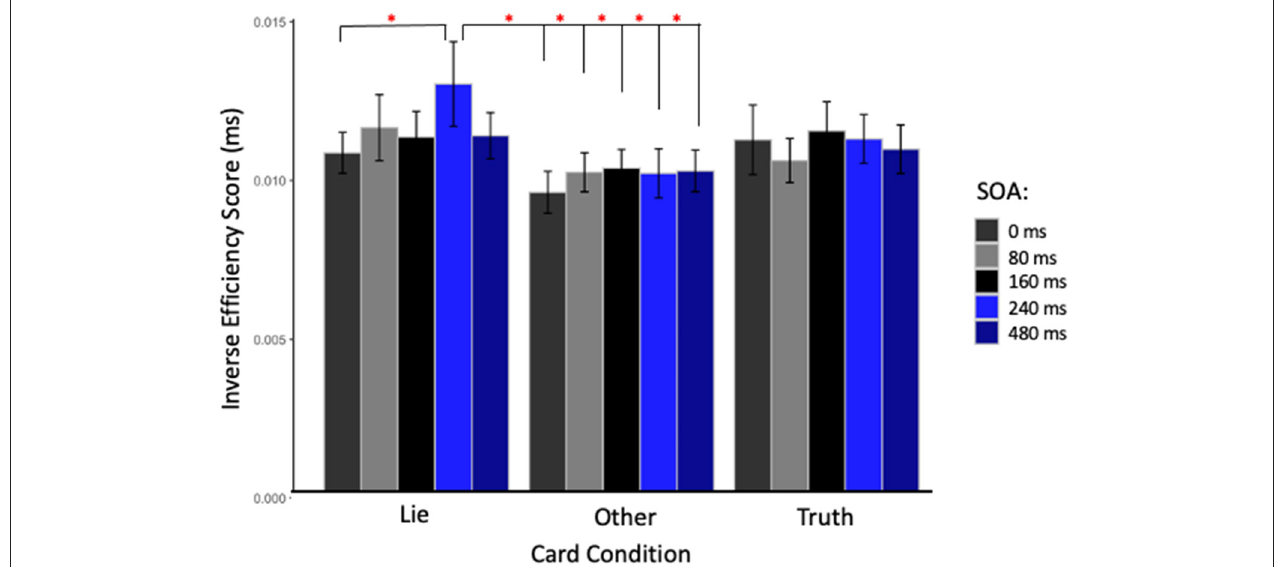
FIGURE 3 | Inverse efficiency score (IES) in milliseconds for TMS applied over the parietal cortex at each SOA and for each card type. Red stars indicate significant IES difference when stimulation was applied at 240ms after the stimulus onset and subjects were asked to lie, compared to when stimulation was applied at 0ms in the same condition; or to any other timing when subjects were asked to being truthful about cards not in hand.